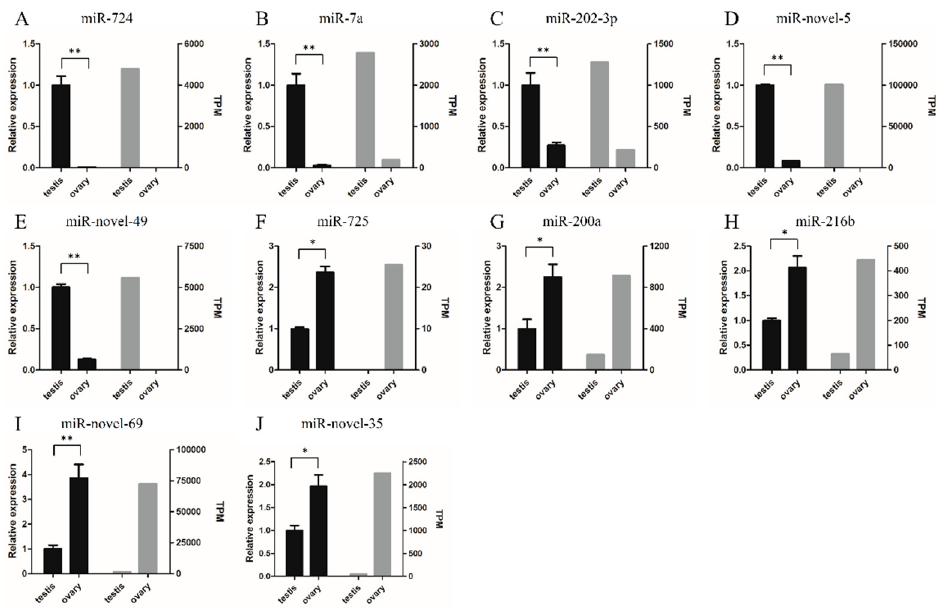
Figure 5. Expression patterns in qRT-PCR (left) and RNA-seq (right). Student’s t test, * p < 0.05 and ** p < 0.01.